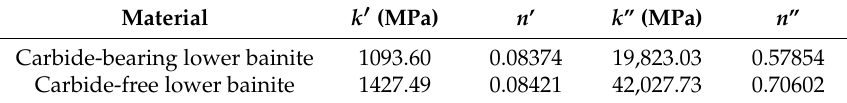
Figure 5. ( a ) Cyclic stress-strain curve; ( b ) variation of the degree of softening and the degree of hardening for the carbide-bearing and carbide-free bainitic steels. Table 4. Summary of the cyclic mechanical properties.